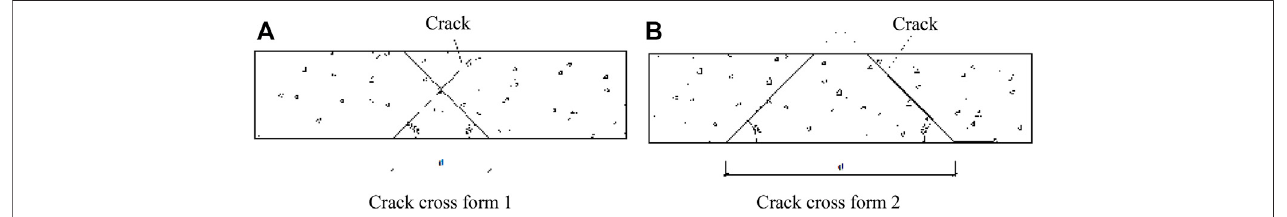
FIGURE 1 | Two types of cracks (Xie, 2018). (A) Crack cross form 1 and (B) Crack cross form 2.